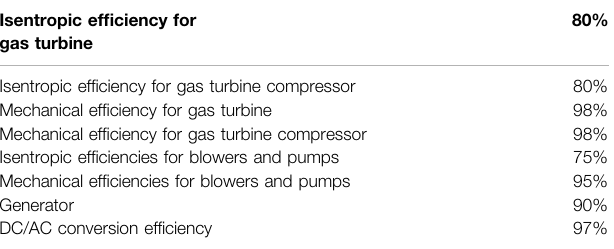
TABLE 3 | Important operating parameters assumed for the gas turbine unit.